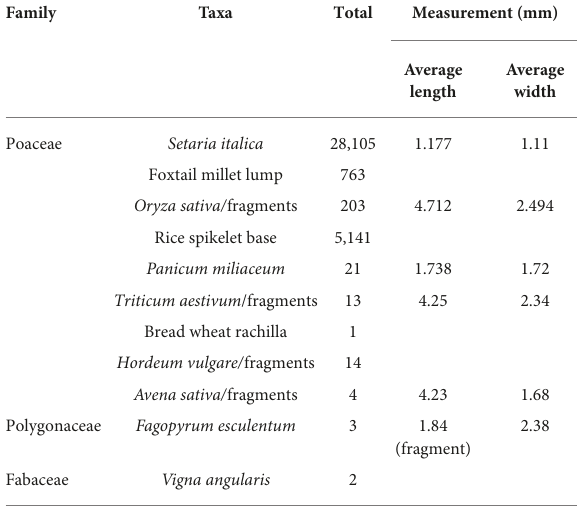
TABLE 2 The quantity and measurement for crops at Wanfunao.